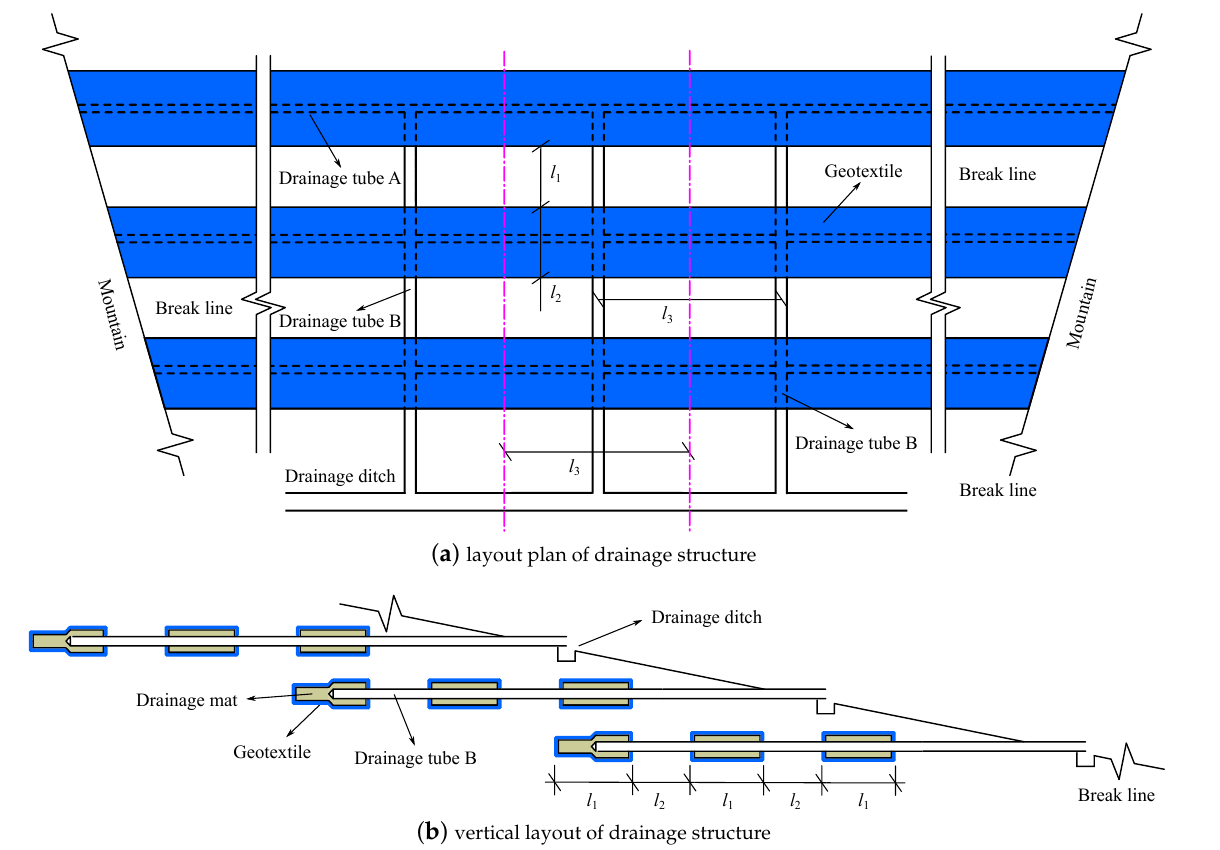
Figure 2. The layout of the drainage structure in a tailings dam. The drainage mat, geotextile, and drainage tube A are illustrated in Figure 1 in detail. The domain between two dash-dotted lines in Figure 2a is used to establish quasi-3d